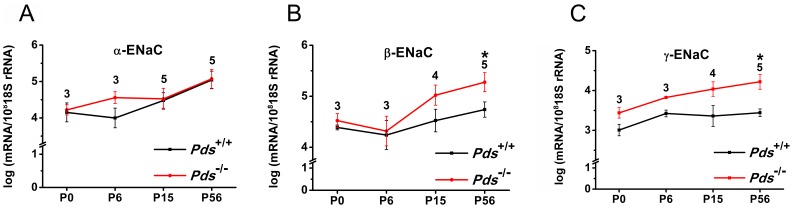
Differences of transcript expression of αENaC (A), βENaC (B), and γENaC (C) in the cochlea between Pds+/+ and Pds−/− mice.The transcripts of β and γENaC were significantly upregulated at P56 in Pds−/− compared with Pds+/+ mice. *p<0.05, numbers above the bars represent the number of experiments.